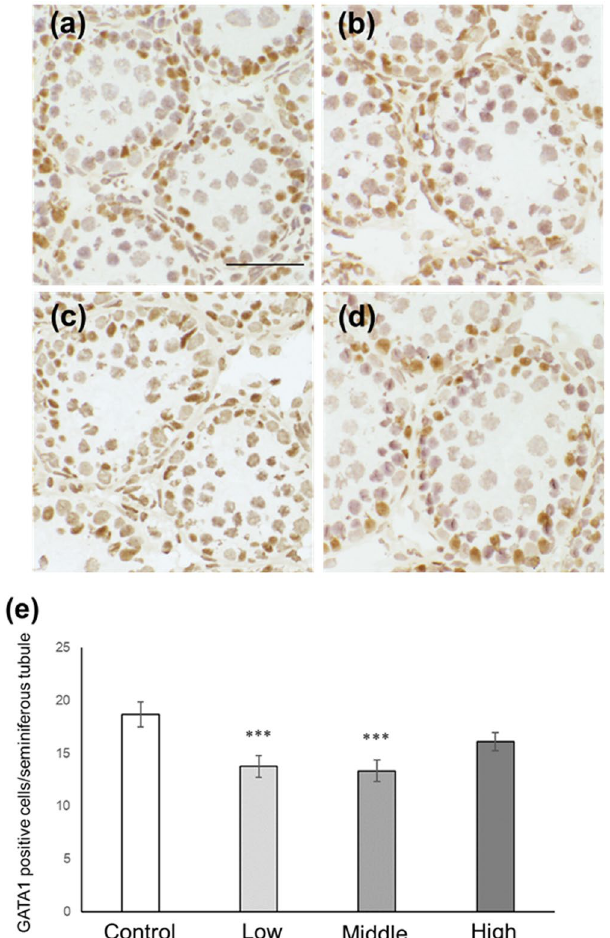
Figure 8. Number of GATA-1-positive Sertoli cells in CORT-administered mice on PND 16. Representative micrographs of Sertoli cells immunostained with anti-GATA-1 antibody in the testes from control ( a ), low- dosed ( b ), middle-dosed ( c ), and high-dosed-CORT mice ( d ) on PND 16. The scale bar is 50 µm. GATA- 1-positive cells per seminiferous tubule among the control and CORT mice ( e ). Values are expressed as the mean ± S.E.M of data from 10 animals per group (10 seminiferous tubules per animal). ***p < 0.001 compared to the